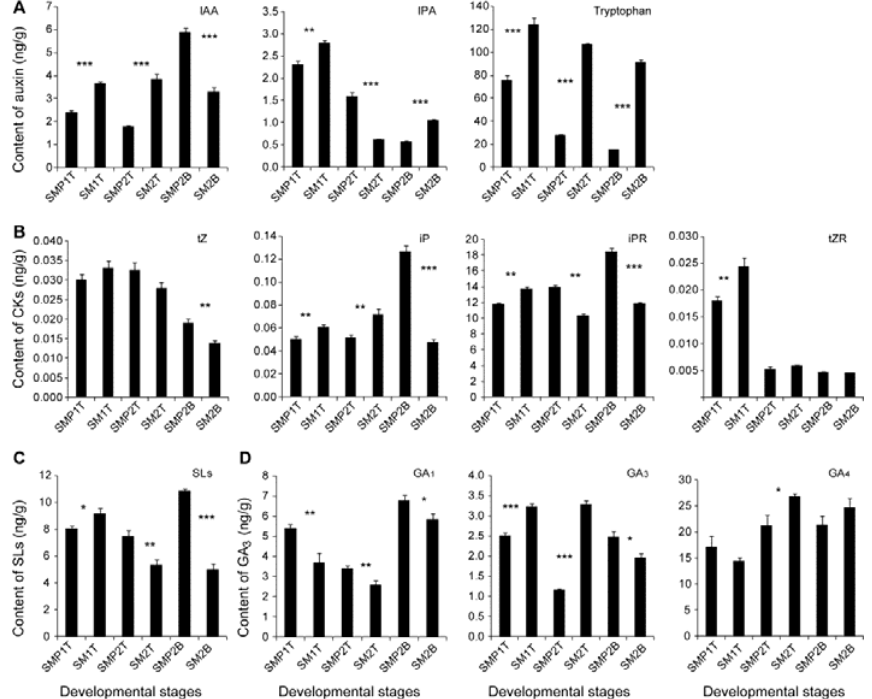
Figure 1. Changes in the variation of endogenous hormones at different developmental stages: auxin ( A ), CKs ( B ), SLs ( C ), and GAs ( D ). SM and SMP represent S. matsudana and S. matsudana var. pseudo ‐ matsudana , respectively. 1T, 2T, and 2B represent the stem apex (T) and basal branch (B) at the two different developmental stages. Error bars represent SE ( n = 3). *, p < 0.05; **, p < 0.01; ***, p < 0.001. CKs, cytokinins; SLs, strigolactones; GAs, gibberellins; IAA, indole ‐ 3 ‐ acetic acid; IPA, indole ‐ 3 ‐ propionic acid; tZ, trans ‐ zeatin; tZR, trans ‐ zeatin riboside; iP, isopentenyladenine; iPR, isopentenyladenosine.